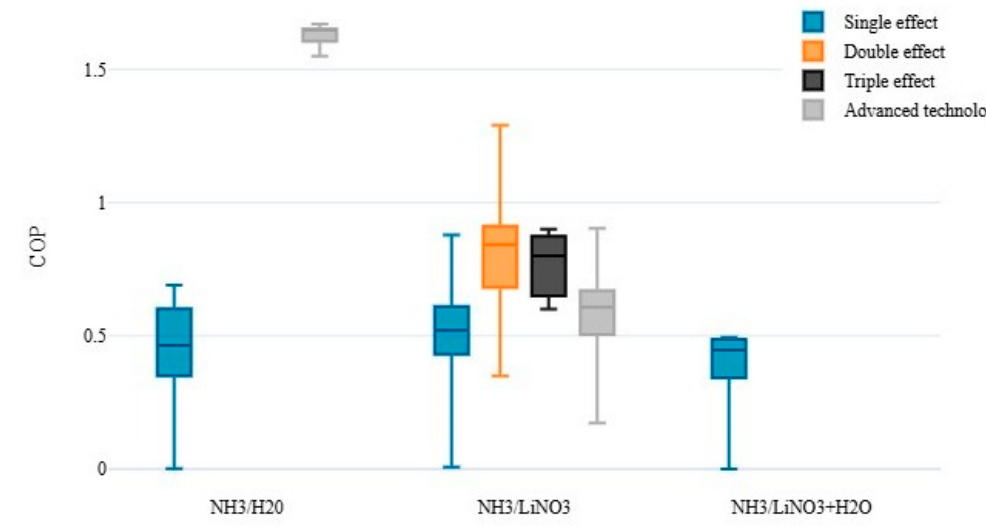
Figure 17. Summary of the COP for each of the three working fluids (NH 3 /H 2 O, NH 3 /LiNO 3 , and NH 3 /LiNO 3 + H 2 O) for each of the four technologies (single, double, triple, and advanced technology). For the NH 3 /LiNO 3 pair, the best COP was found for double- and triple-effect, but also at the cost of a higher driving temperature, which, in this case, limits the application of the technology. The NH 3 /LiNO 3 + H 2 O pair obtained lower COP compared to the previous cases.